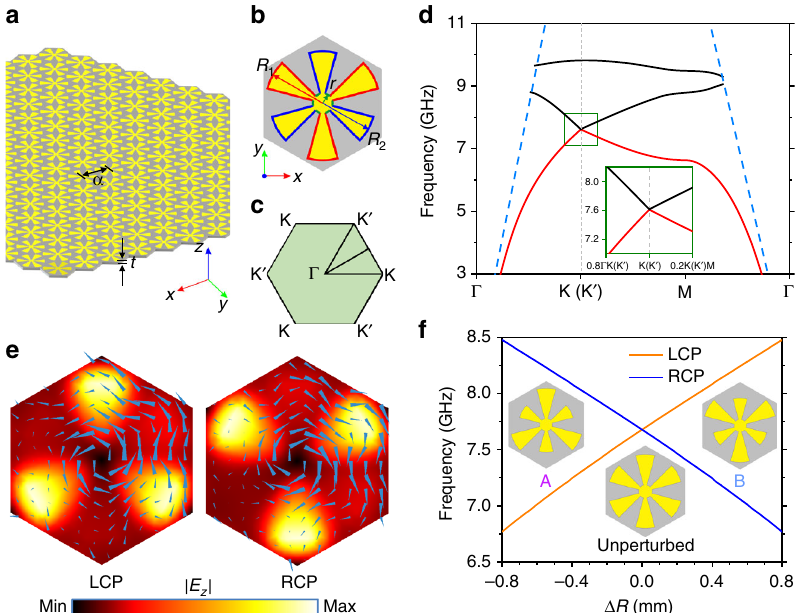
Fig. 1 Conceptual illustration of the DSP crystal and frequency split of circularly polarized valley states. a Schematic illustration of the triangular-lattice designer surface plasmon (DSP) crystal consisting of metallic patterns (yellow) on a dielectric F4B substrate (gray). b Top-view Wigner – Seitz unit cell of the lattice. The metallic pattern consists of an inner circle with radius r = 1 mm and six radial fans with sector angle 30°, three of them marked by red outlines having radius R 1 , the other three marked by blue outlines having radius R 2 . c First Brillouin zone (FBZ) of the triangular lattice. d Calculated band structure of the DSP crystal along the special directions of the FBZ with R 1 = R 2 = 5.55 mm. The blue dashed lines represent the dispersion of EM wave in air (light line) and only the guided part of the band structure is shown. The inset enlarges the area enclosed by the green rectangle around K/K ′ valley, showing the gapless Dirac cone. e Simulated fi eld maps of E z component on the xy plane 1 mm above the surface, showing the two degenerate states at the K valley with energy fl ux represented by blue arrows. The circulating energy fl ux of the states is either left-hand circularly polarized (LCP) or right-hand circularly polarized (RCP). The color indicates the amplitude of E z component. f Calculated eigenfrequencies of the LCP and RCP states at the K valley when the parameter Δ R = R 1 − R 2 varies while the mean radius R = ( R 1 + R 2 )/2 = 5.55 mm is kept constant. The inversion of frequency order of the LCP and RCP states indicates a topological phase transition when Δ R crosses zero. The evolution of the unit cell is indicated in the inset, where pattern A corresponds to Δ R = − 0.5 mm, the unperturbed pattern corresponds to Δ R = 0, and pattern B corresponds to Δ R = 0.5 mm. The difference between R exaggerated for a clearer